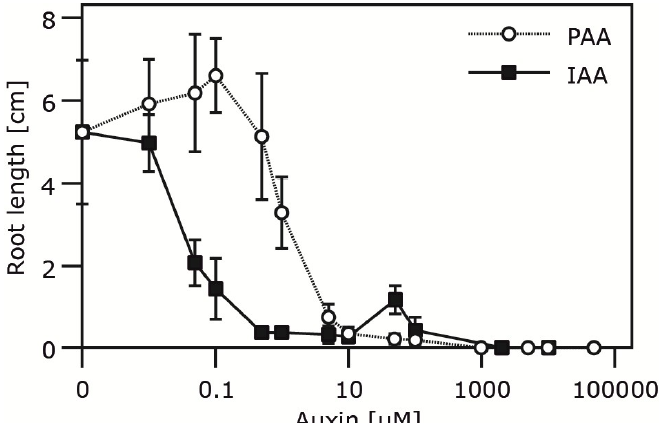
Figure 6. Impact of PAA and IAA on primary root